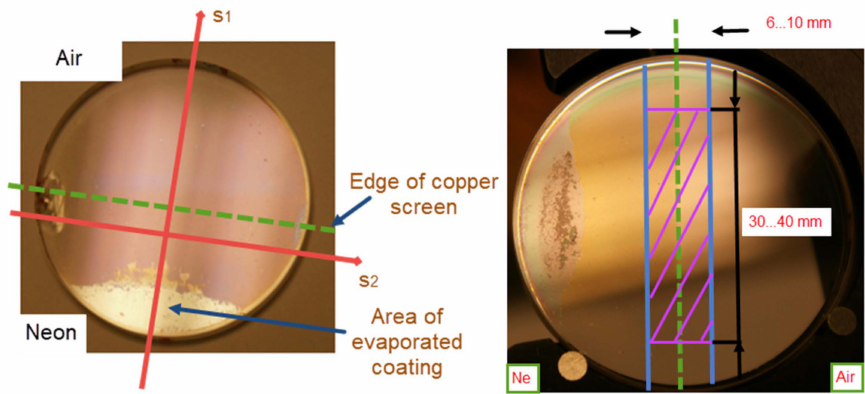
Figure 3. Schlieren images of captured flow structures during irradiation of HfO 2 /SiO 2 ( a ) and Mo/Si ( b ) coatings in neon: 1—shock front from coating, 2—contact boundary, 3—shock front from MPC, 4—sample, 5—copper screen, 6—evaporation front from chamber walls.